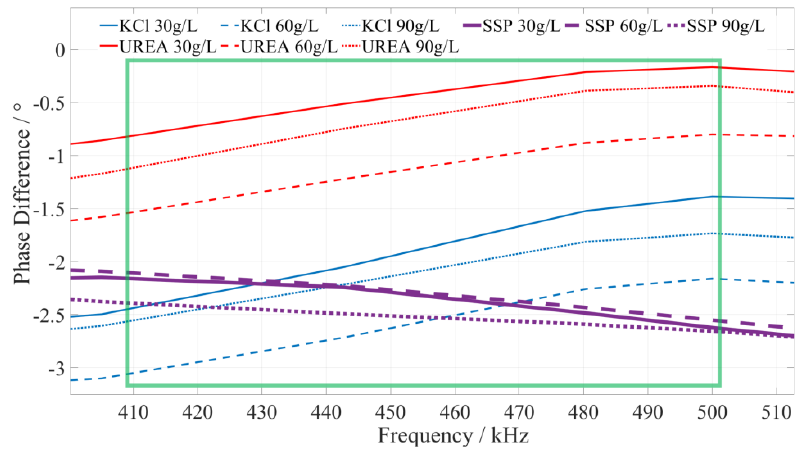
Figure 7. The phase – frequency characteristic curve of superphosphate, urea, and potassium chlo- Figure 7. The phase–frequency characteristic curve of superphosphate, urea, and potassium chloride ride fertilizer solutions under the excitation signal of 410~500 kHz. fertilizer solutions under the excitation signal of 410~500 kHz.